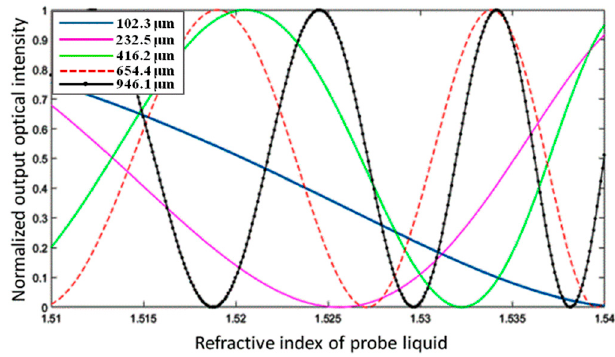
Figure 8. Normalized output optical intensity with various sensing arm length differences.